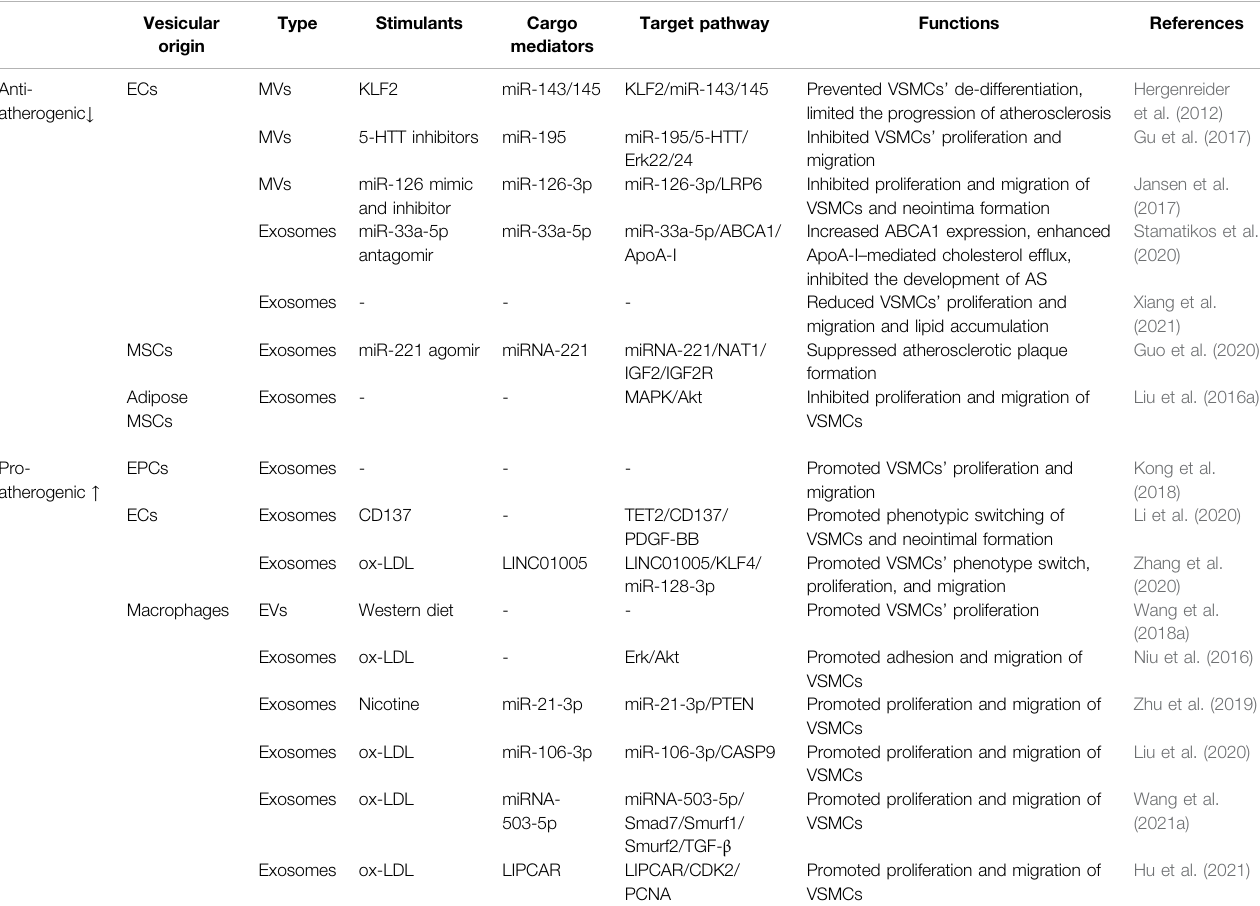
TABLE 1 | EVs-mediated crosstalk between multiple cells and VSMCs in AS. Vesicular